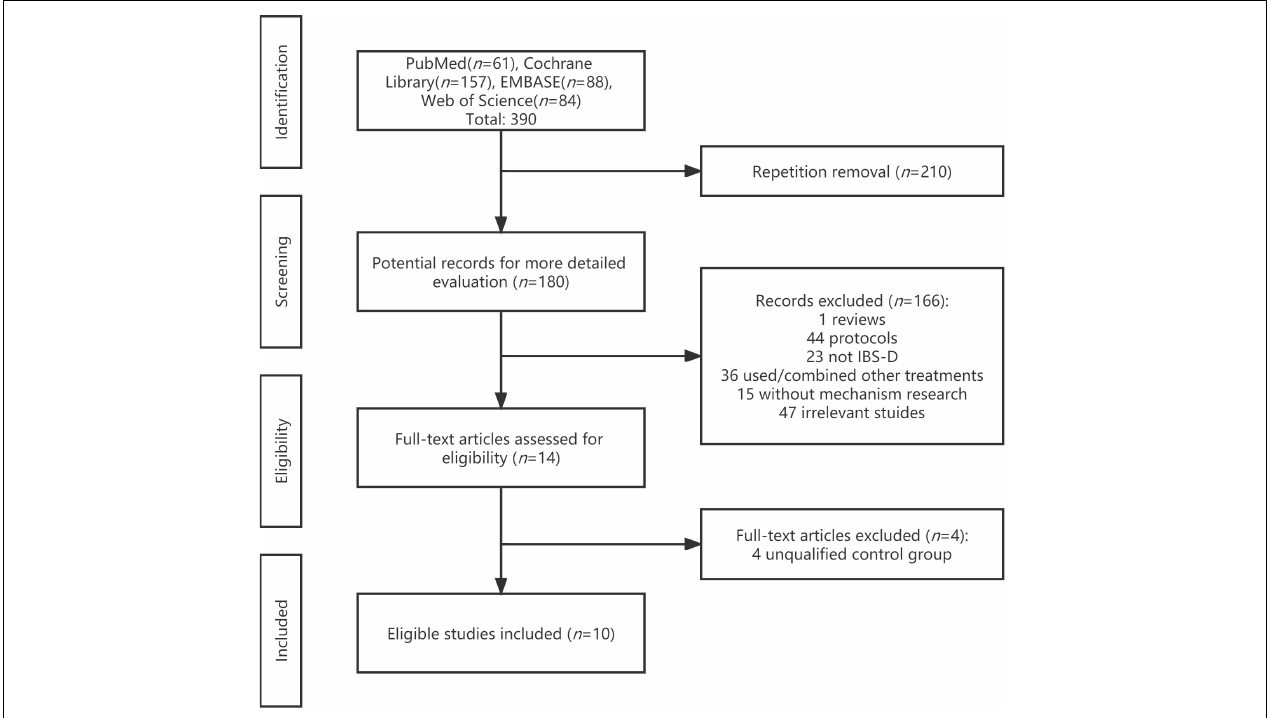
FIGURE 1 | Process of study selection based on